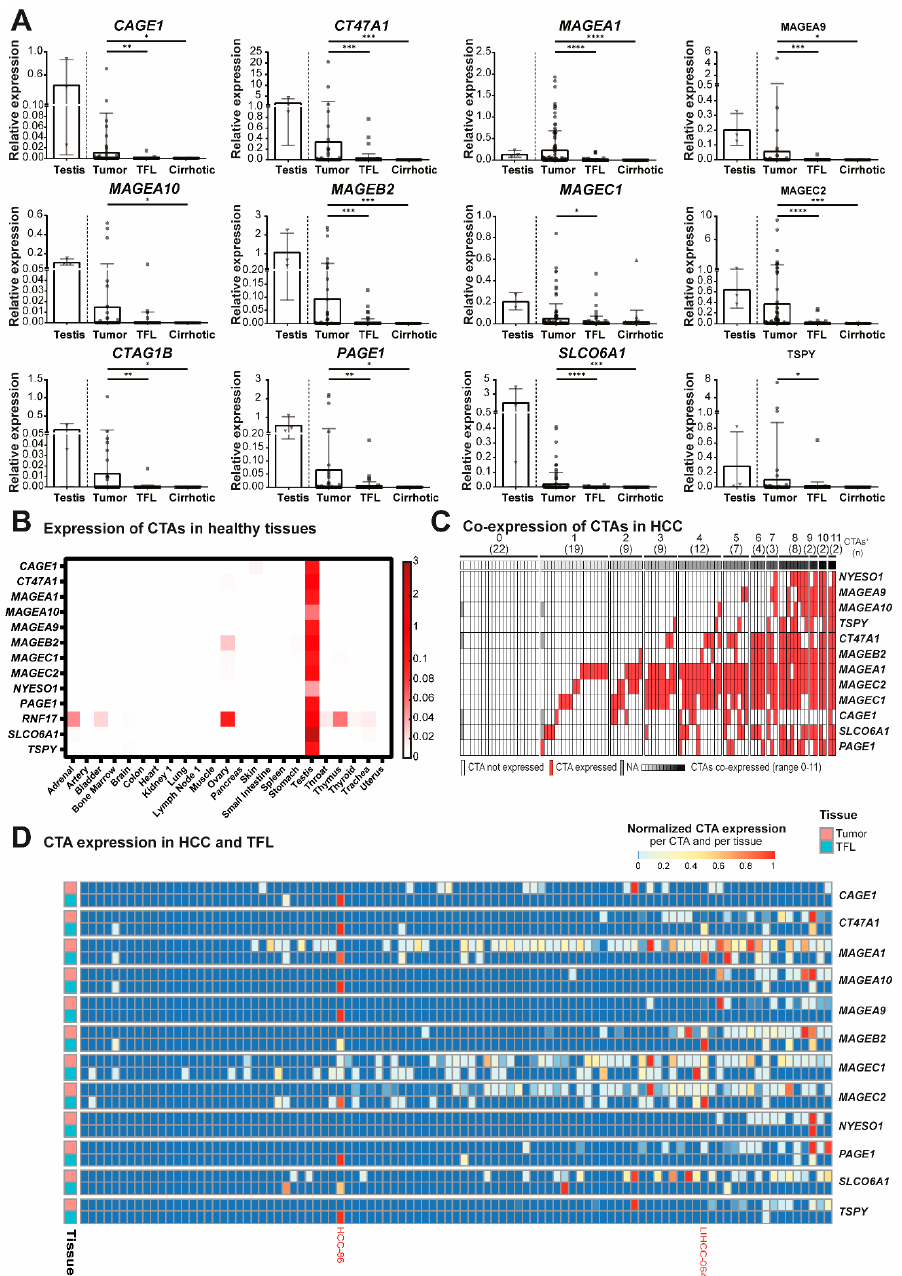
Figure 2. Panel of 12 CTAs expressed in >10% of HCC tumors, but not in healthy tissues. mRNA expression of 12 CTAs in 100 paired HCC and TFL tissues, 35 cirrhotic tissues and 22 different adult healthy tissues, as determined by RT-qPCR. ( A ) mRNA expression of the 12 CTAs that are expressed in more than 10% of HCCs and not in healthy tissues. Dots show individual patient tissues, bars show the mean relative expression level, and error bars show the standard deviation. Wilcoxon signed-rank test, * p < 0.05, ** p < 0.01, *** p < 0.001, **** p < 0.0001. ( B ) Heatmap indicating relative mRNA expression levels of all CTAs that are expressed in >10% of HCCs, in healthy adult tissues. ( C ) Heatmap indicating co-expression of CTA mRNA in tumor tissue ( D ) Heatmap of mRNA expression of the 12 CTAs expressed in ≥ 10% of HCC tumors (rows), in HCC tumors and TFL for every patient (columns). Patients were ordered by number of CTAs expressed in each individual tumor. The – ∆ Ct values were used and for normalization this data was scaled between 0 and 1 for each CTA in each tissue [((x-(min(x))/(max(x)-min(x)))]. Colors correspond to the value between 0 and 1 and patients LIHCC-064 and HCC-86 are highlighted in red. Heatmap was made in R, using the pheatmap